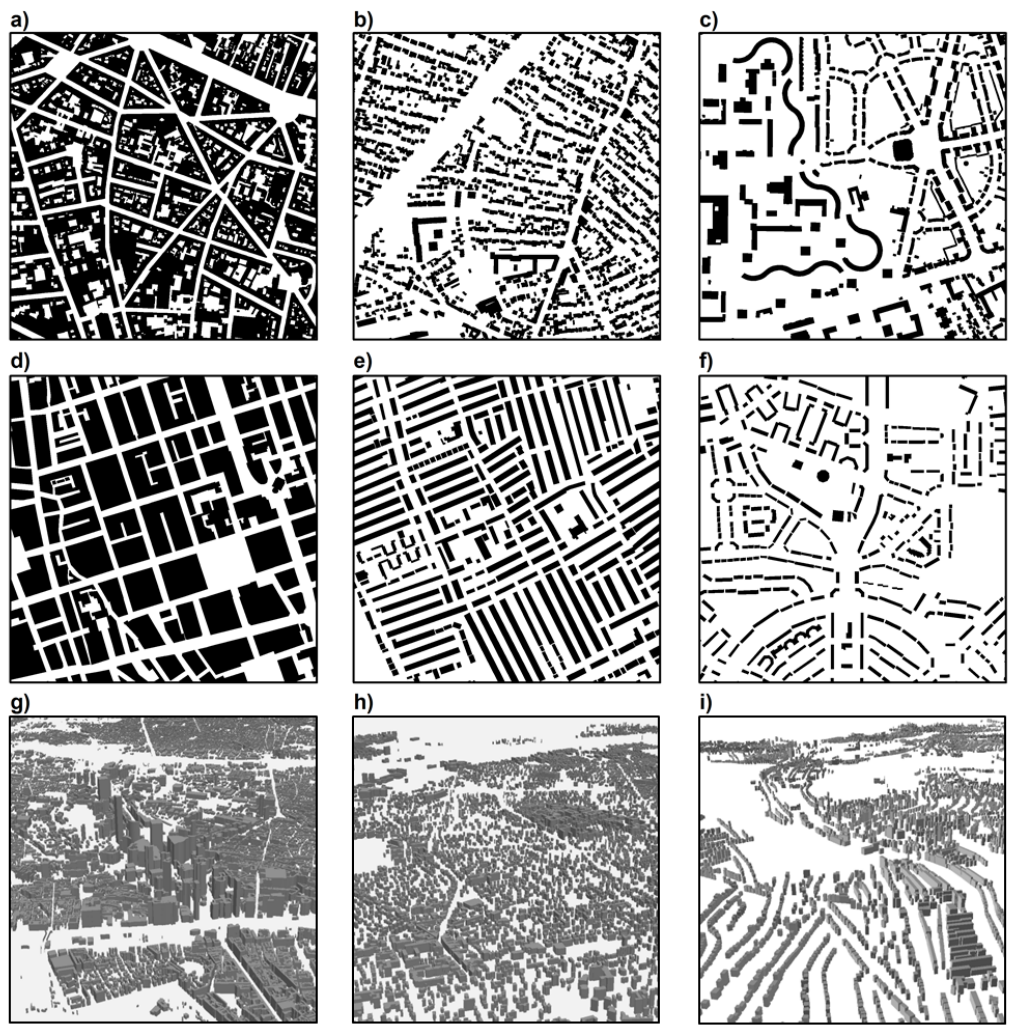
Figure 12. Ground figure plans for characteristic generic structural types: High building density for ( a ) Paris and ( d ) London; Medium building density for ( b ) Paris and ( e ) London; Low building density for ( c ) Paris and ( f ) London; ( g ) High floor space density and ( h ) medium density housing development in Paris; and ( i ) row house structures in suburbs (Purley) of London.